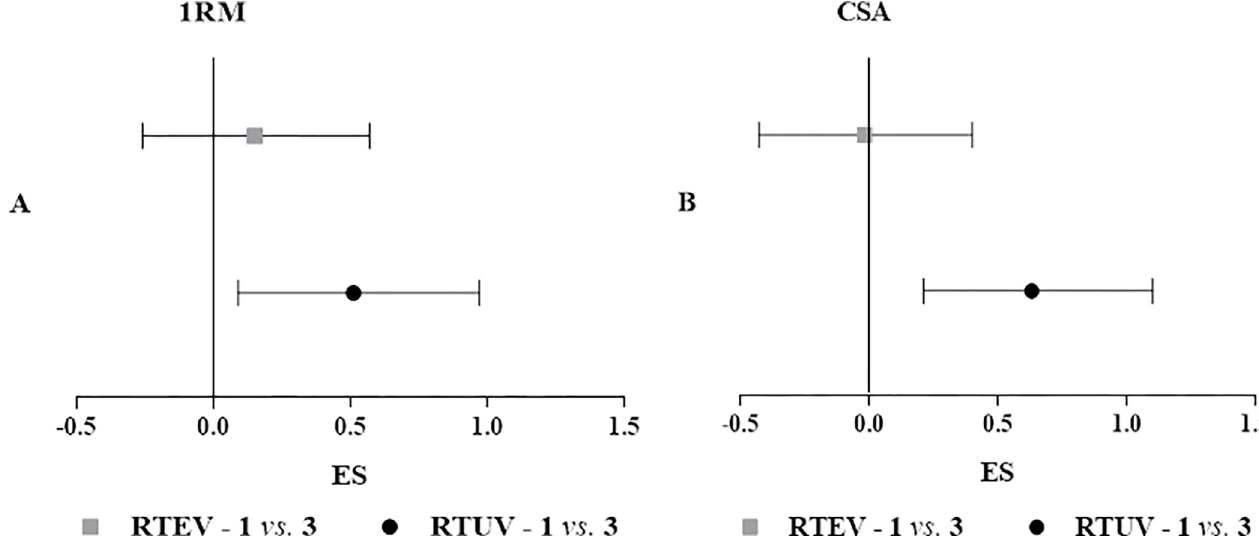
Fig 3. Effect sizes with the confidence interval for 1RM (A) and CSA (B) values at different resistance training frequencies of RTEV and RTUV. ES, effect size; 1RM, maximum dynamic strength; CSA, quadriceps femoris cross-sectional area; RTEV, resistance training with equalized total training volume and; RTUV, resistance training with unequalized total training